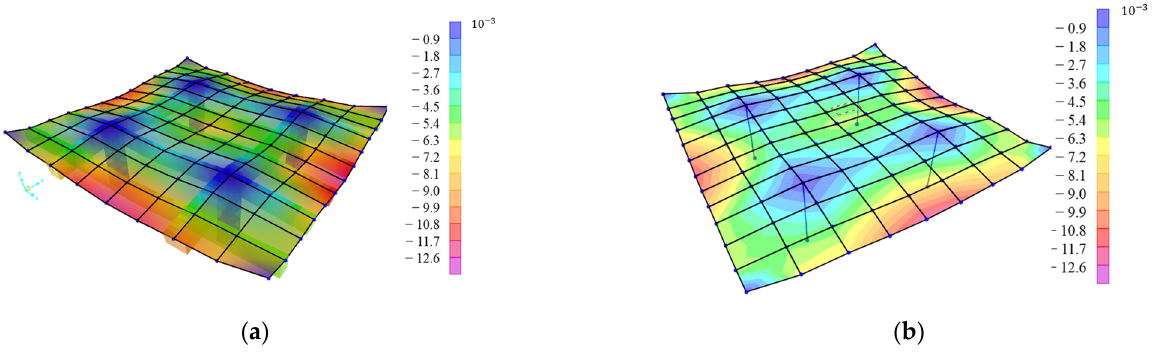
Figure 13. Structural analysis results: ( a ) Based on existing drawings; ( b ) Based on reverse engineering drawing.